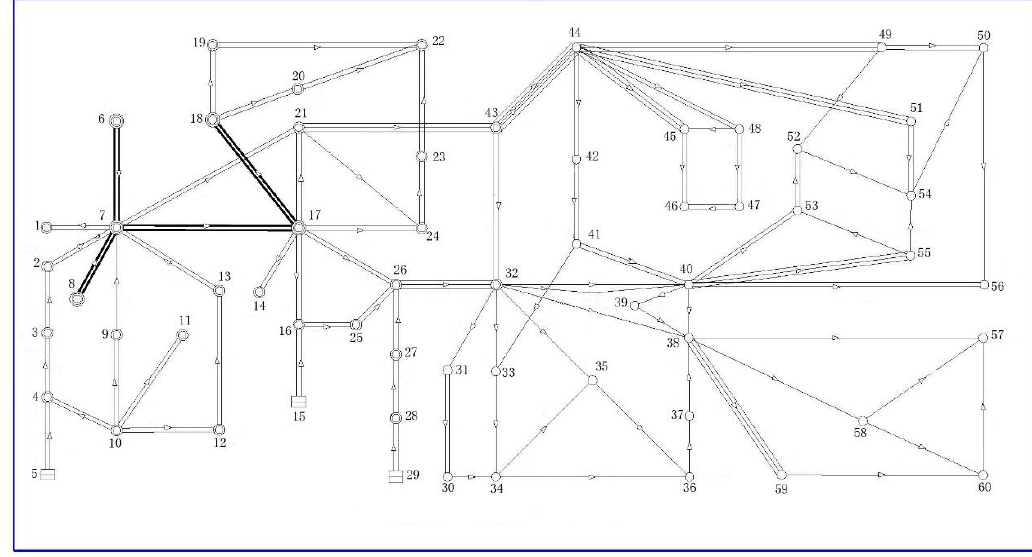
Figure 1. Energy Internet (EI) simulation model.